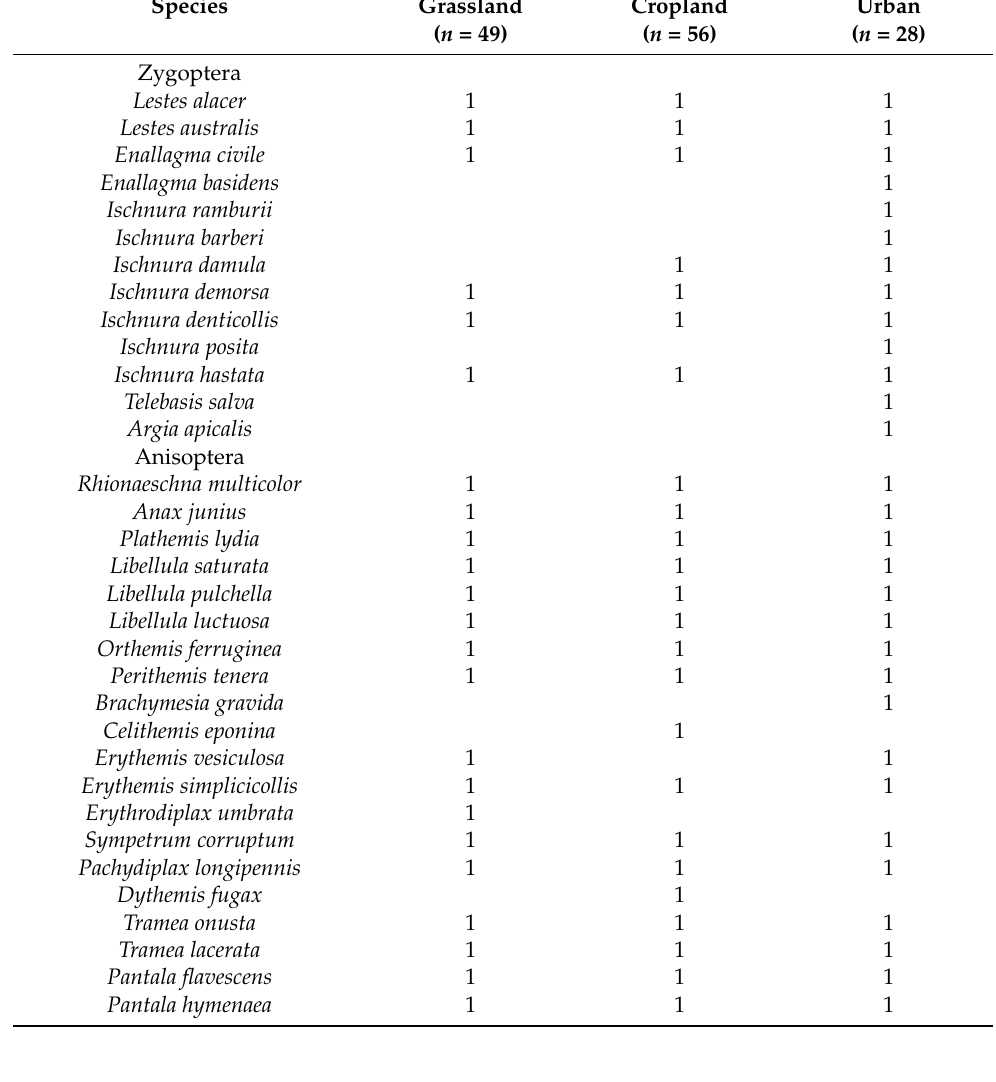
Table 1. Odonate species occurrences (“1” indicates presence) listed taxonomically in playa wet- lands characterized by the dominant land use/land cover type within 200 m, Texas panhandle